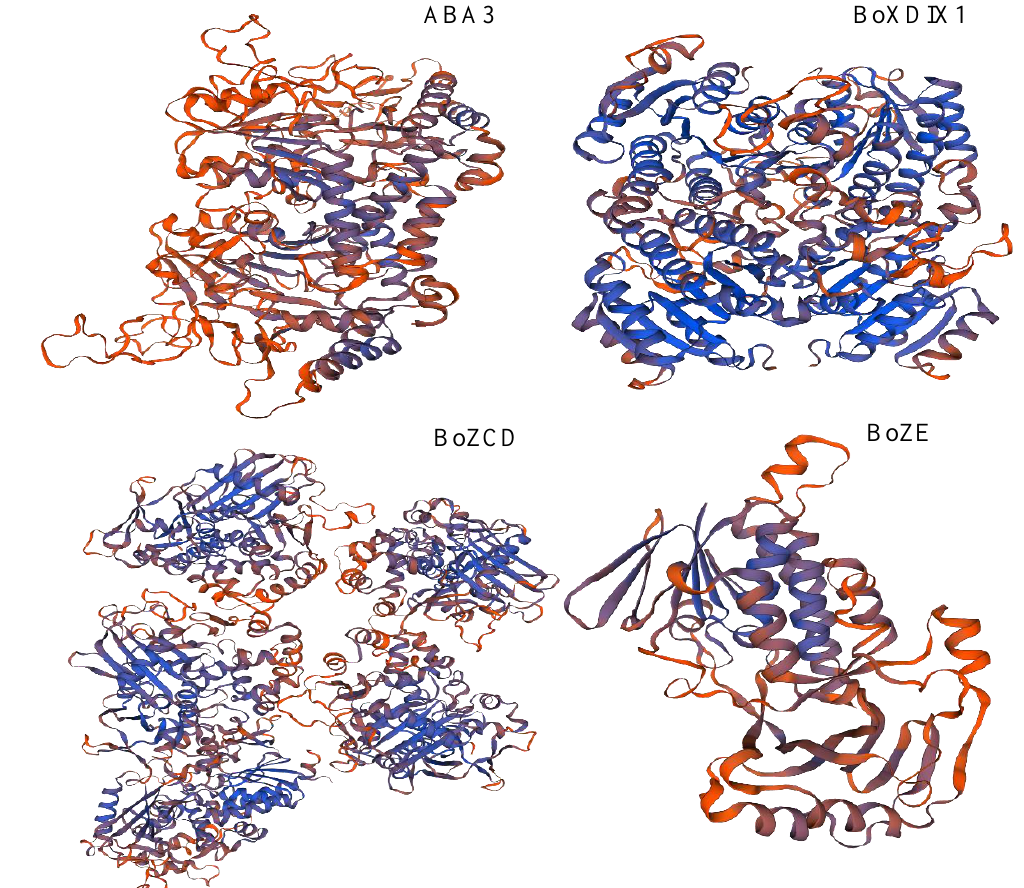
Figure 4. Predicted 3D structures of interactome